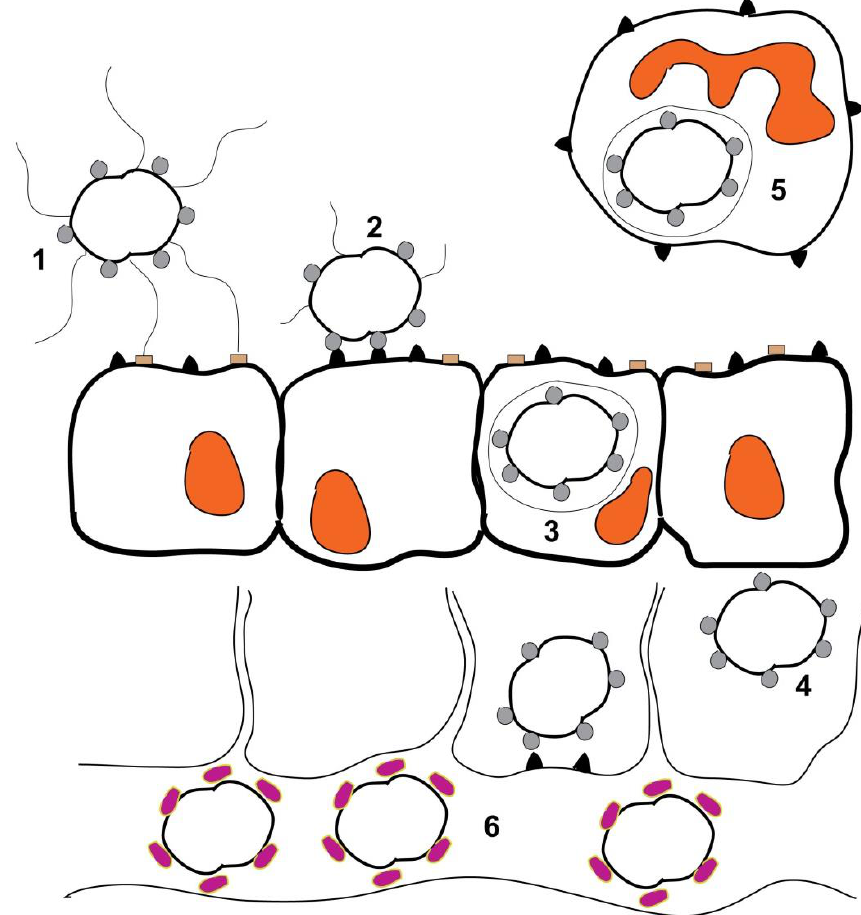
FIGURE 1: Schematic represen- tation of a Neisseria